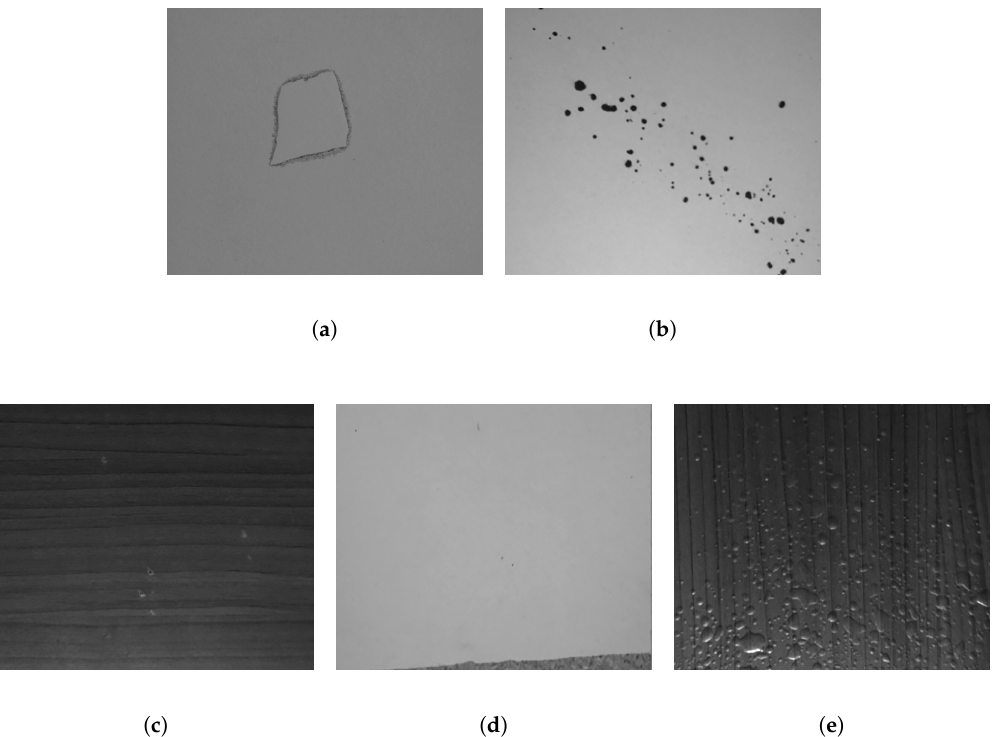
Figure 1. Example of different defects that can appear in melamine boards (( a )Paper scrap, ( b ) Stains, ( c ) White spots, ( d ) Paper displacement, ( e )